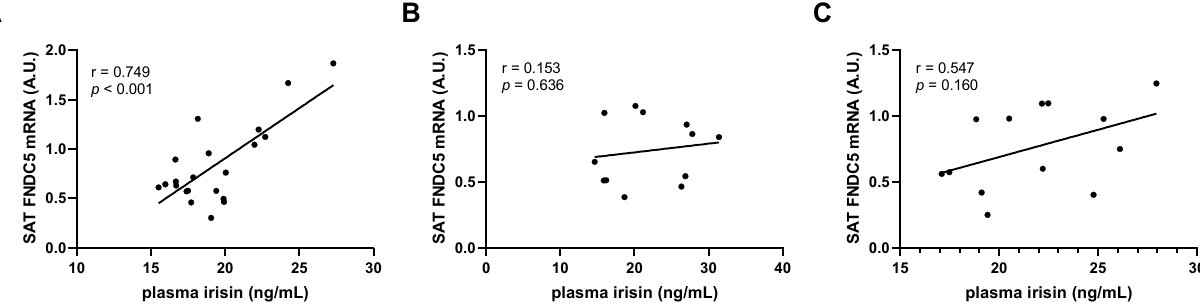
Figure 2. Association of circulating irisin and subcutaneous adipose tissue FNDC5 gene expression in type 1 and type 2 diabetic mice. Pearson’s correlation coefficients of plasma irisin with subcutaneous adipose tissue (SAT) FNDC5 mRNA levels in ( A ) streptozotocin-induced type 1 diabetic and control mice, ( B ) high-fat diet-induced obese and normal diet-fed mice, and ( C ) genetically obese db/db mice and db/m controls. A.U. = arbitrary units.